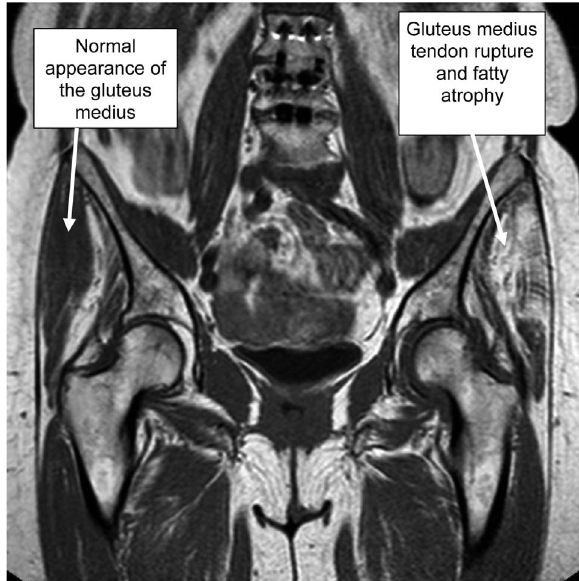
Figure 3. Hip abductor damage on MRI. Shown is the coronal T1- weighted MR-image at the level of the greater trochanter of a 72 year old female patient, complaining of severe lateral hip pain on the left side, radiating down to the knee. The greater trochanter is very tender on palpation and the patient presents with a reduced walking distance and difficulties during the gait cycle. The Hip Lag Sign was positive on the left side.